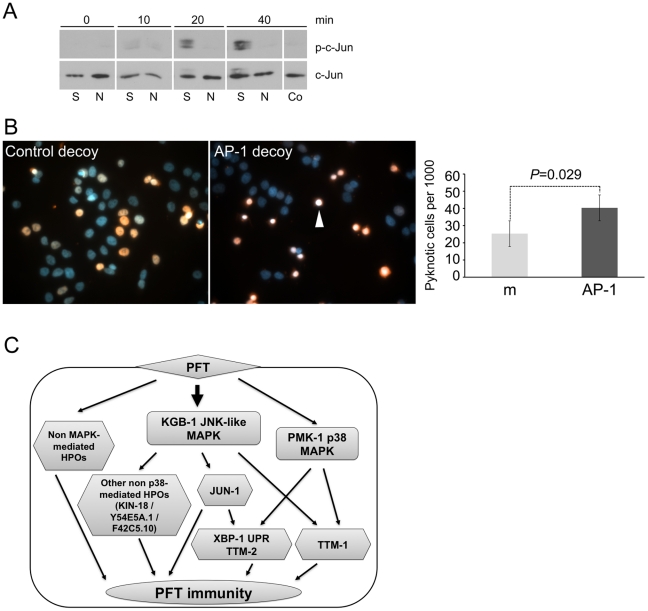
AP-1 protects against mammalian PFTs.(A) Western blot of mammalian c-JUN in HaCaT cells treated with 125 ng/mL SLO for time indicated. Abbreviations: S: constitutively active version of SLO, N: non-lytic mutant N402 SLO; Co: no-SLO control. (B) HaCaT cells were treated with SLO and biotinylated AP-1 decoy-oligonucleotide (right panel) or biotinylated control oligonucleotide (left panel). Oligonucleotide is stained red (SA-Alexa594), and DNA is stained blue (4',6-diamidino-2-phenylindole/DAPI). The images presented are a single representative from three independent assays. Cells treated with AP-1 decoy show a greater proportion of intoxicated cells with condensed chromosomes, characteristic of becoming pyknotic (e.g., white arrowhead). The proportion of pyknotic cells was quantified as described in the Materials and Methods section; the bar graph shows mean values from three independent experiments (m = mismatched oligonucleotide; AP-1 = AP-1 decoy; error bars: standard error of the mean, P value was determined with paired, one-tailed student's t-test). (C) A model for interconnected regulation of defense to PFT. The KGB-1 JNK-like MAPK regulates both p38 MAPK–dependent (e.g., ttm-1, ttm-2, UPR) and p38 MAPK-independent (e.g., jun-1, kin-18) PFT-induced protection genes. There are also PFT protection genes that, to date, have not been linked to either MAPK pathway.